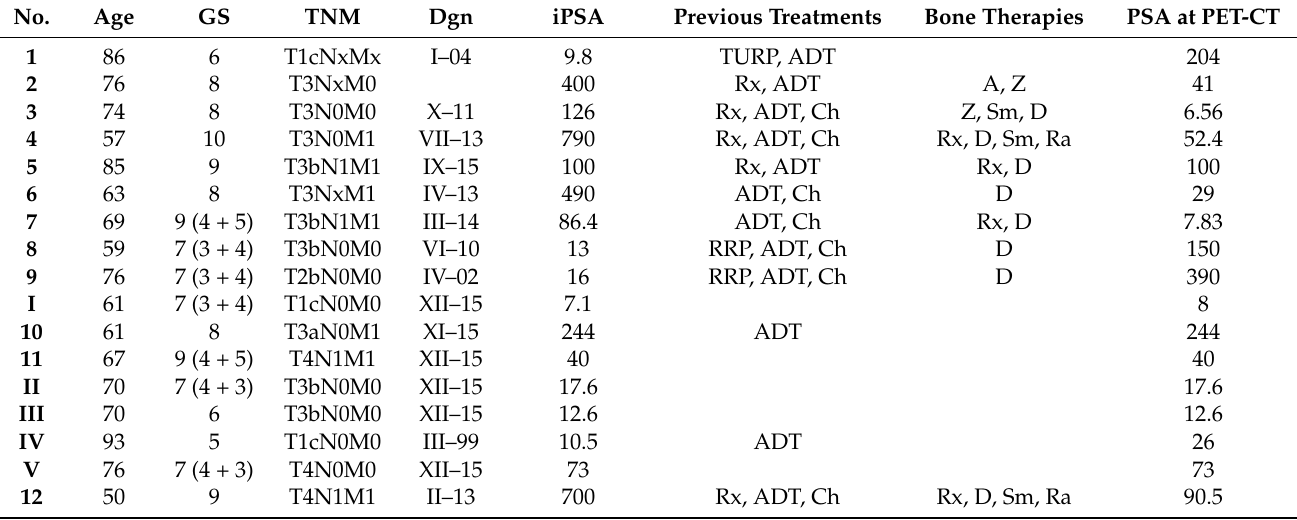
Table 1. Patient characteristics. Age, Gleason score (GS), TNM classification, time of diagnosis, initial S-PSA, previous treatments, skeletal therapies and S-PSA at the time of analysis. Abbreviations: ADT—androgen deprivation, Ch— chemotherapy, Rx—radiotherapy, A—abiraterone, D—denosumab, Ra—radium-223, Sm—Sm-153, Z—zolendronate. Arabic numbers refer to patients with skeletal metastases (M) and Roman numbers to patients with no skeletal disease